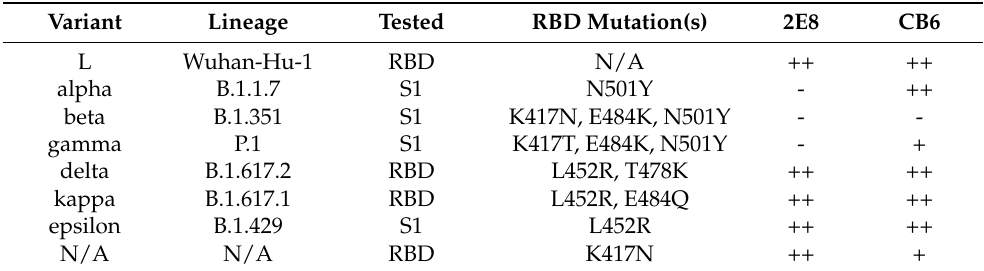
Table 2. The binding of 2E8 and CB6 to SARS-CoV-2 spike proteins. Variant Lineage